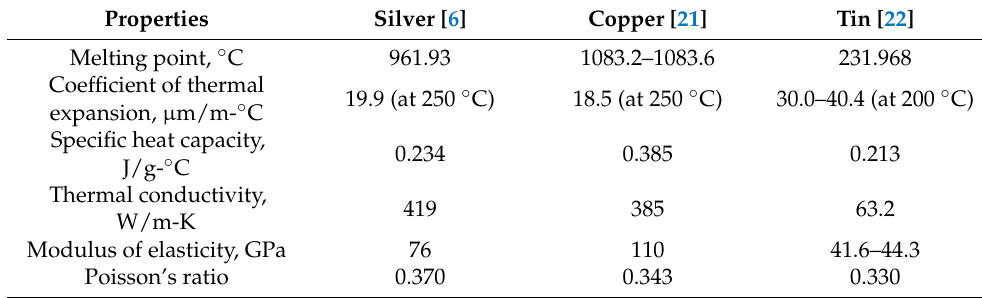
Table 1. Properties of silver, copper, and tin.